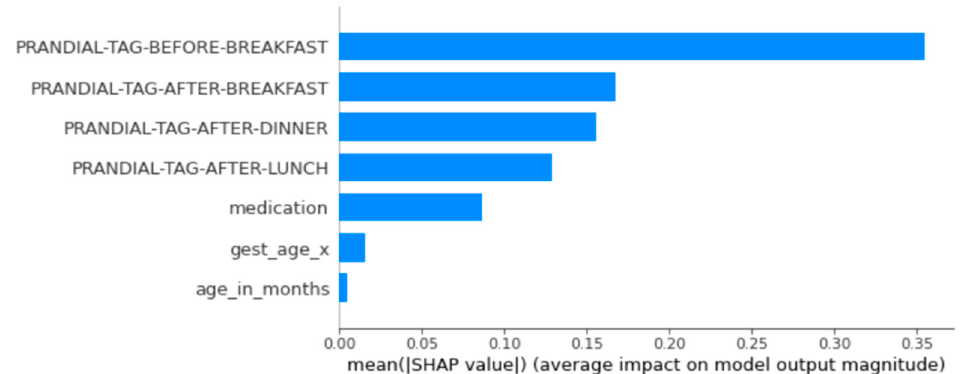
Figure A4. SHAP feature importance ranking for model trained on Tags, Gradients, and High-Read- ings.